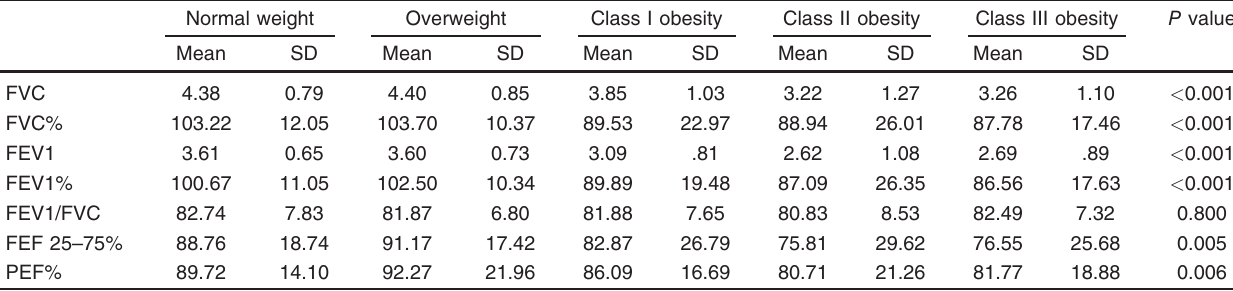
Table 2 Mean values for pulmonary function parameters Normal